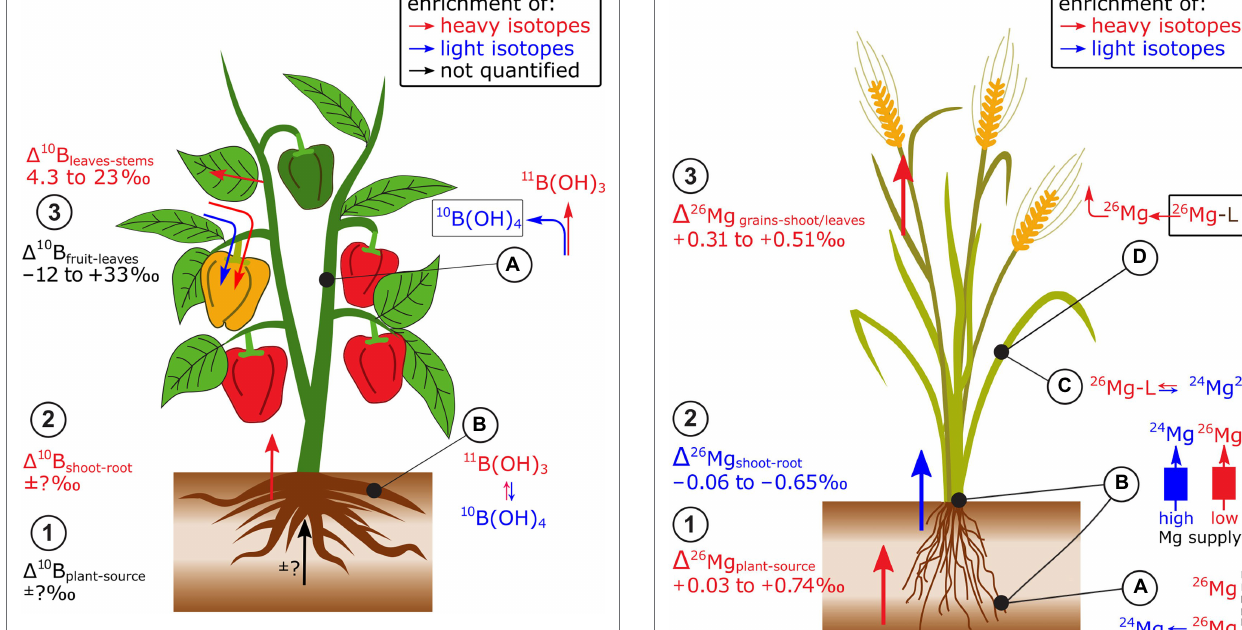
FIGURE 2 | A few studies have investigated B isotope fractionation in plants. Bell pepper has been most systematically investigated. (1) Due to lacking B mass balances, Δ 11 B plant-source is not known, but it can be semi-quantitatively shown that (2) shoots are enriched in heavy isotopes compared to roots. (3) Within plants, leaves are enriched in heavy B isotopes compared to stems while leaves can be heavier and lighter than reproductive organs. (A) At equilibrium, boric acid (B(OH) 3 ) is isotopically heavier than borate (B(OH) 4 − ) which may contribute to the isotope fractionation between root and shoot.